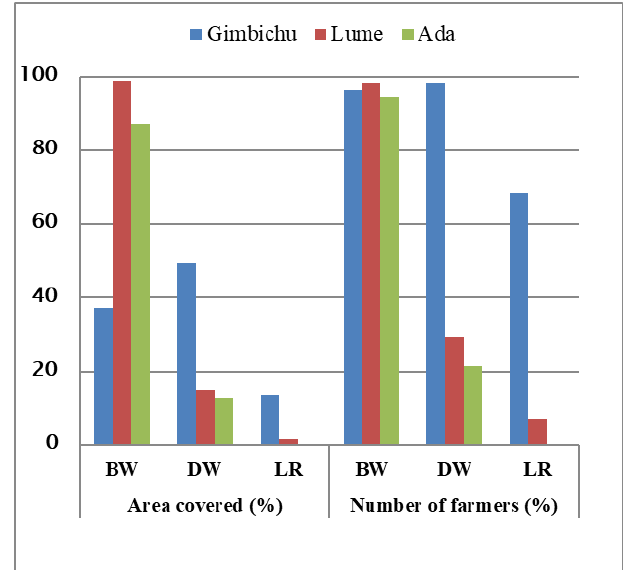
Figure 4. Percentage of landraces (LR) and modern bread wheat (BW) and durum wheat (DW) varieties by area coverage and number of farmers in three districts based on interviews with 149 farmers in